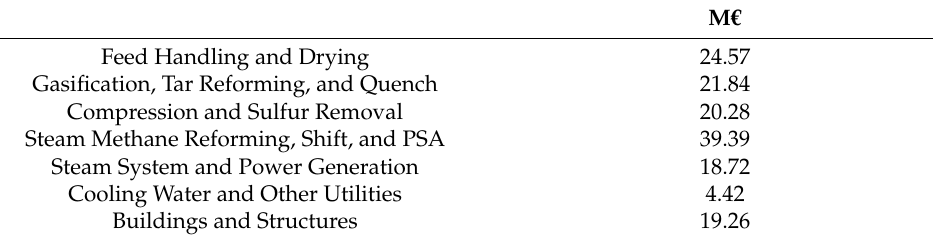
Table 1. Direct capital costs at chemical baseline (installed, to be scaled).